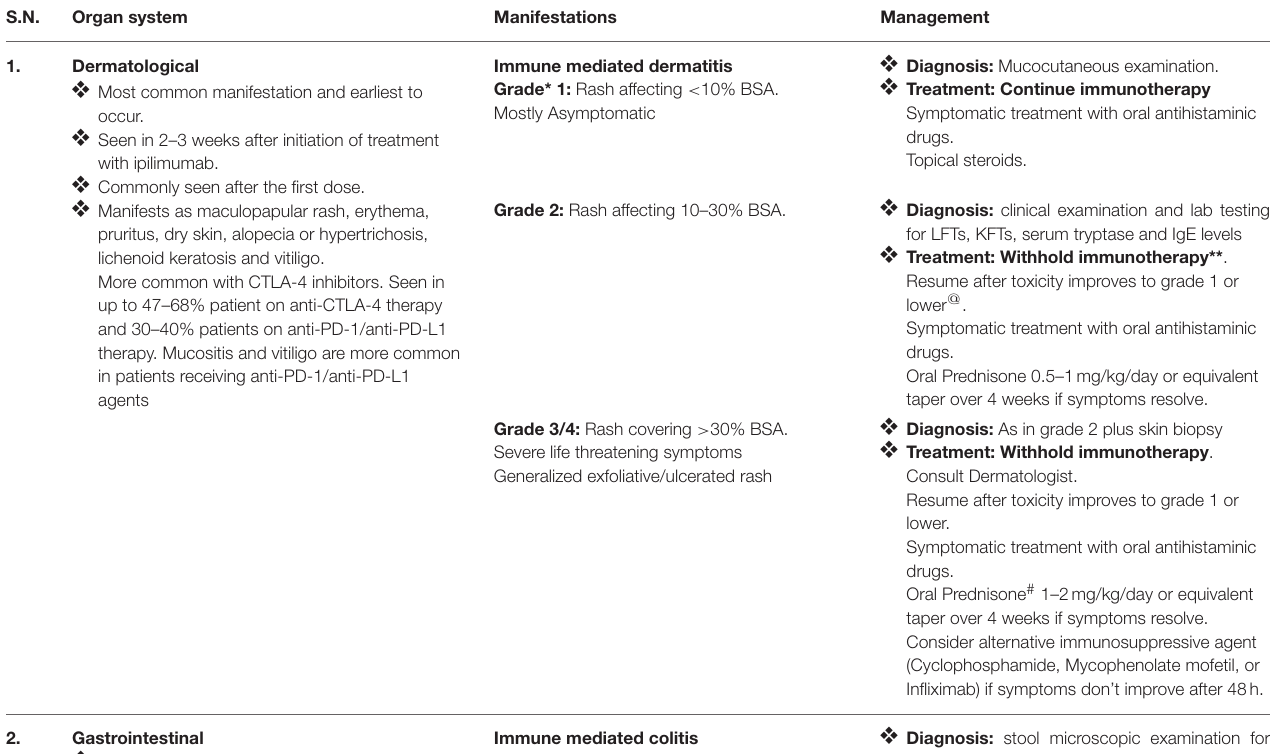
TABLE 2 | Summary of management of selected immune related adverse events (irAEs).